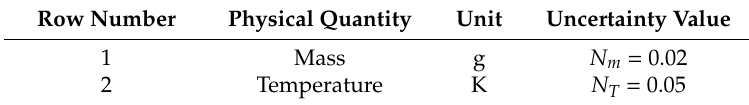
Table 2. Measurement uncertainty values of the instruments used. Row